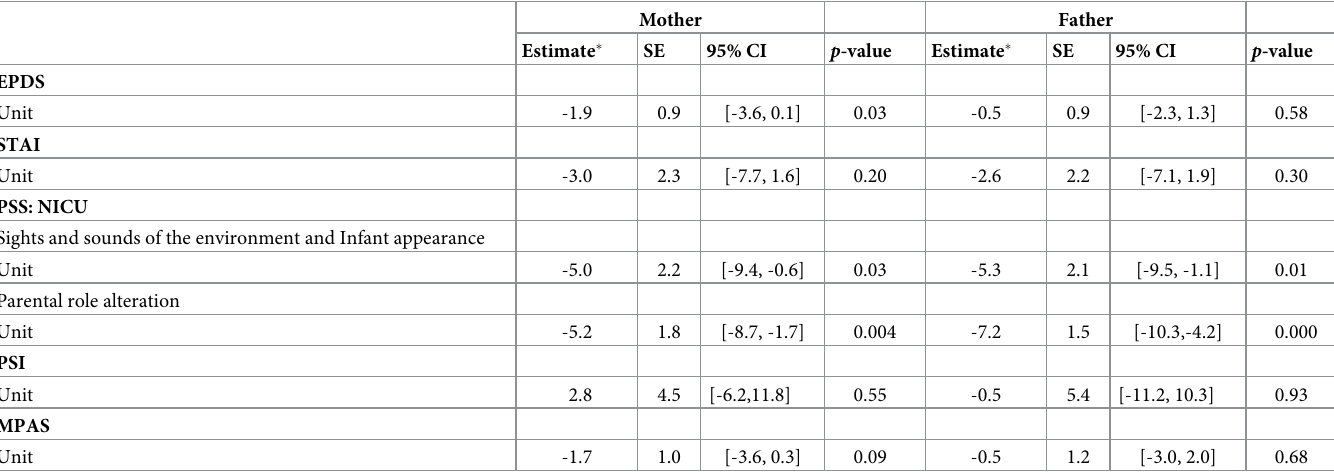
Table 2. Repeated measurements of depression, anxiety, stress and attachment by parents, presented as adjusted mean difference examined in linear mixed